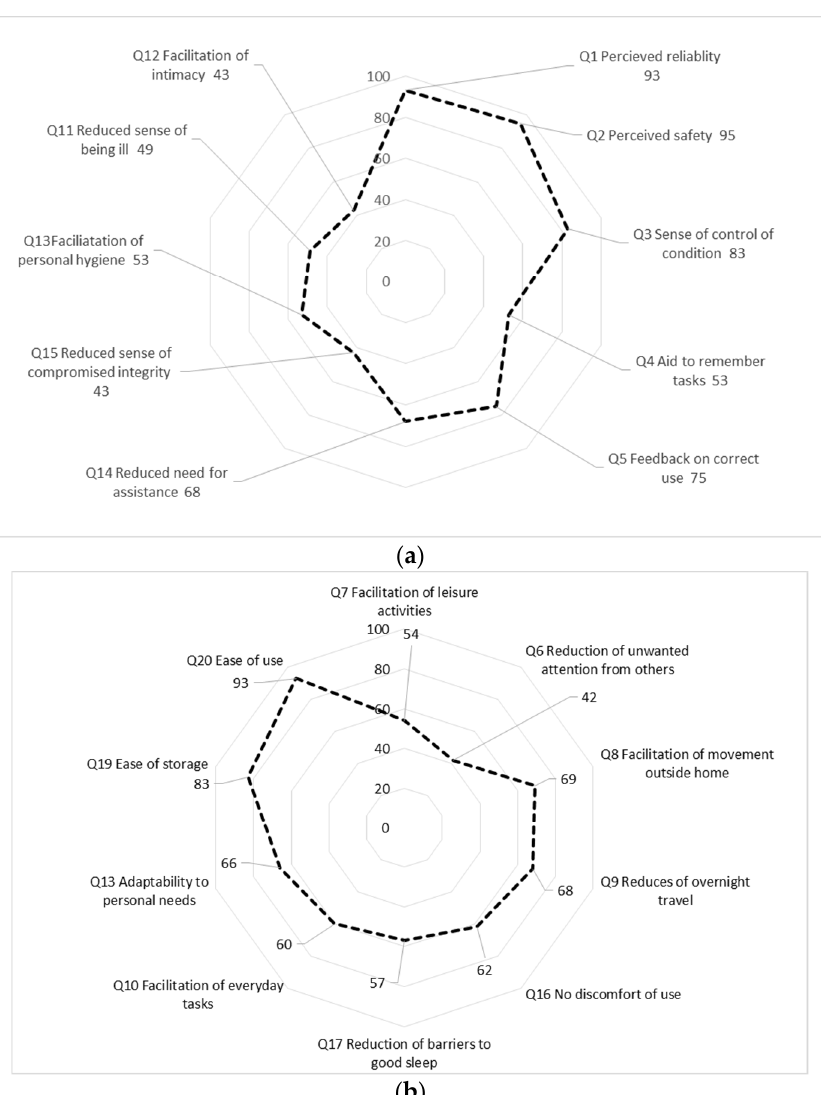
Figure 1. ( a ): Relative frequencies of responses of at least level 3 of 7 “agree”) to each question (Domain Sense of security question 1–5; Domain Integrity, Q 11 to 15); ( b ): Relative frequencies of responses of at least level 3 of 7 (“agree”) to each question (Domain Social participation Q7–9, 16; Domain Convenience, Q 10,